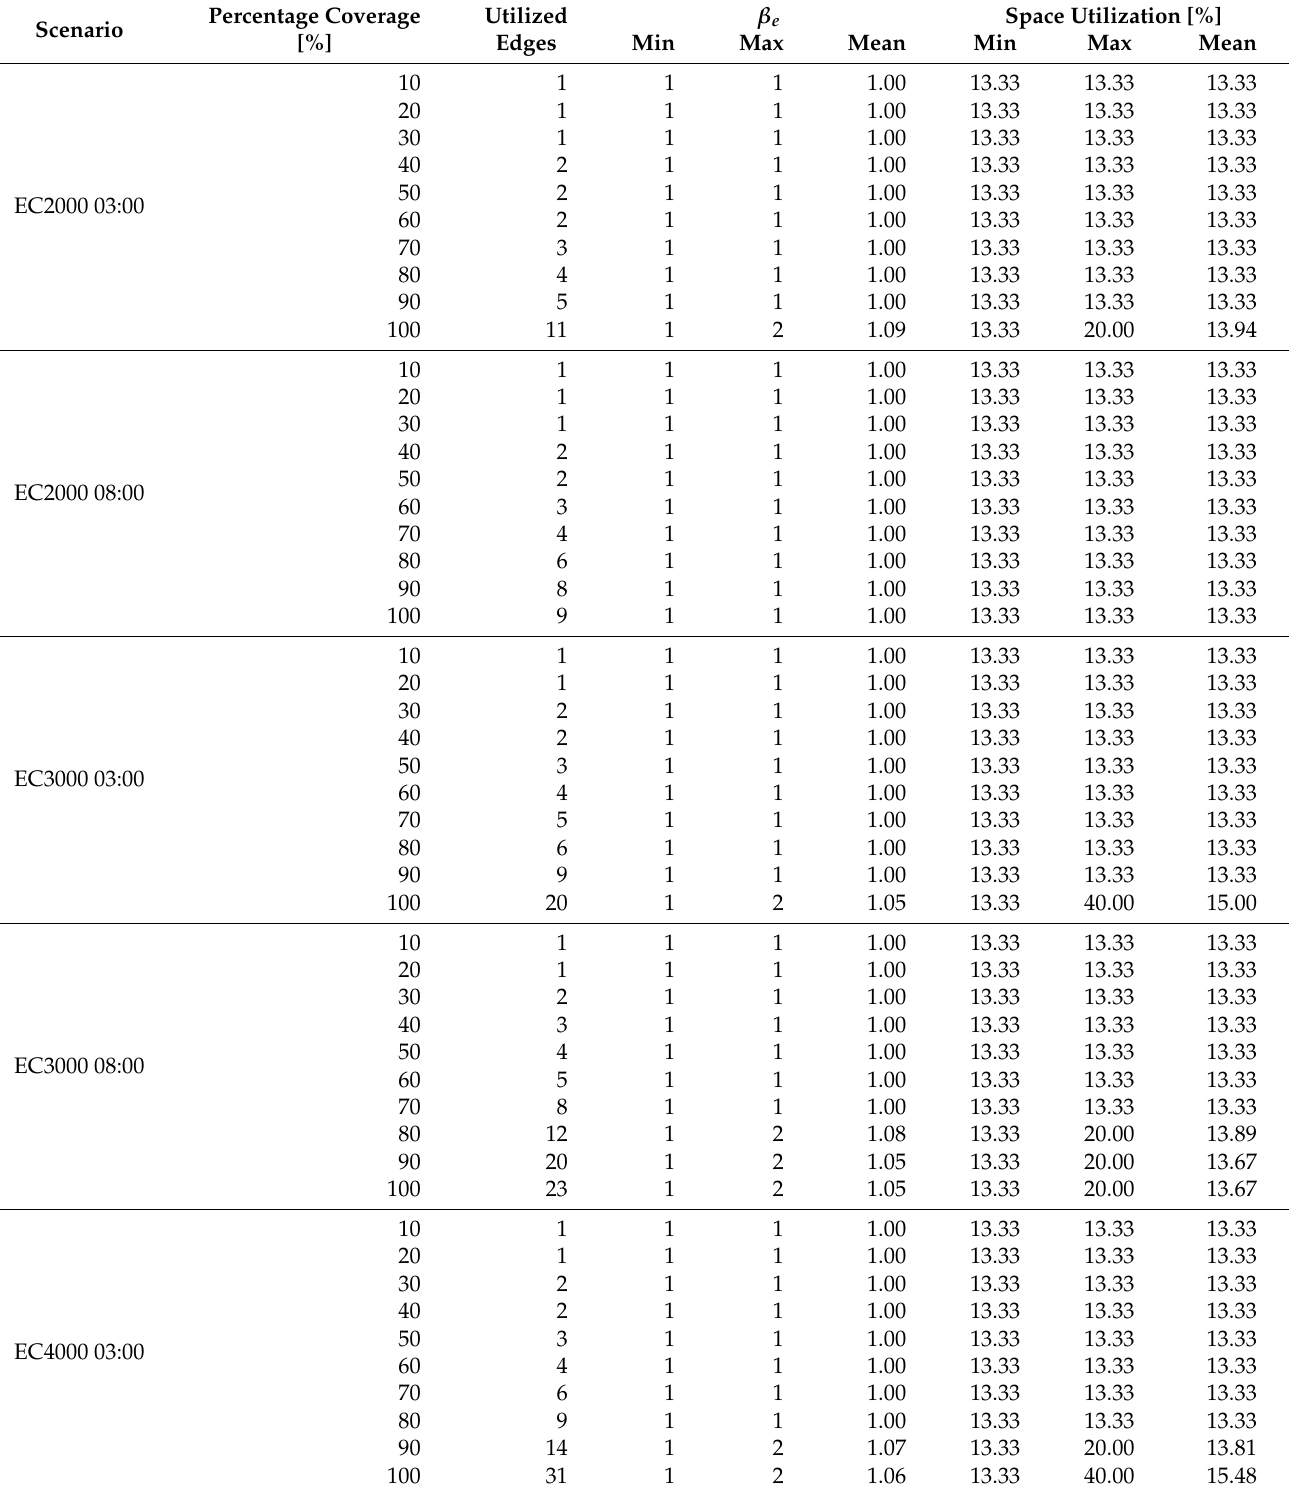
Table A1. Aggregated statistics of space utilization in the edges of dataset 1 test